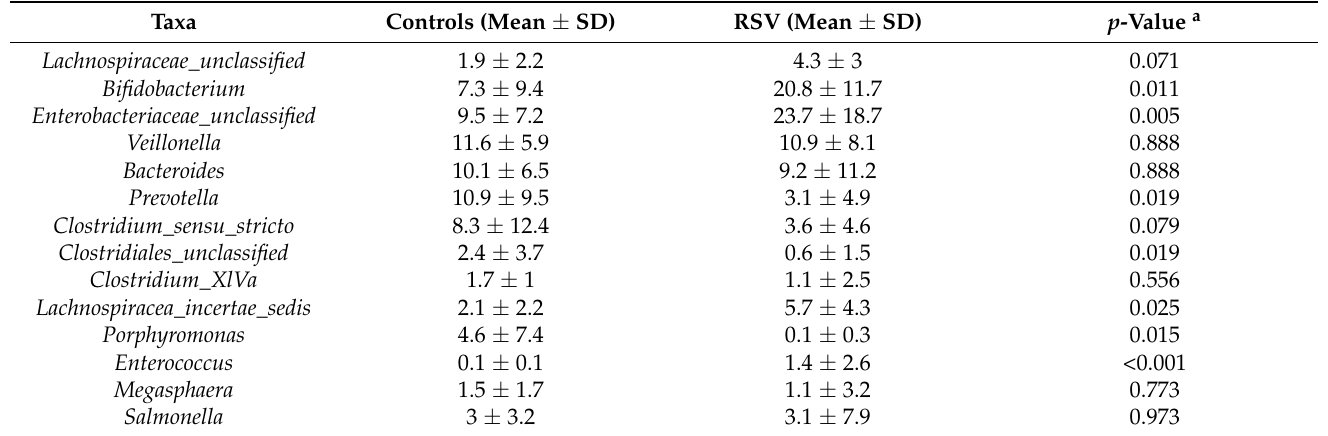
Table 2. Relative abundance of bacterial genera in RSV and control infants at a single timepoint.